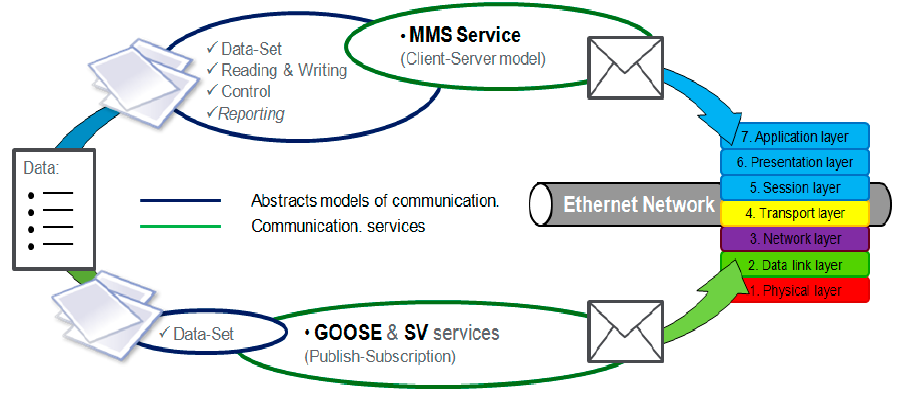
Figure 8. Abstracts models and communication and services.